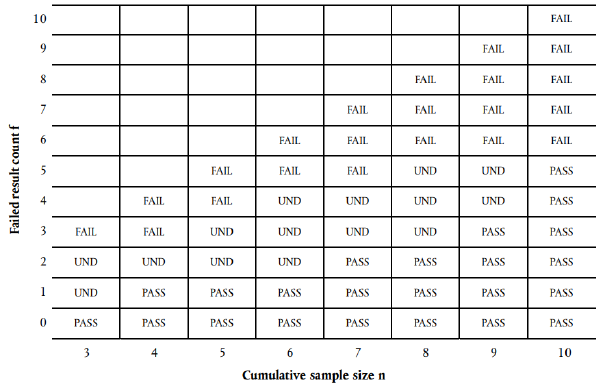
Fig. 4. Decision chart for the ISC statistical procedure applying for type- approved vehicles from January 1 st 2020 (UND: undecided)